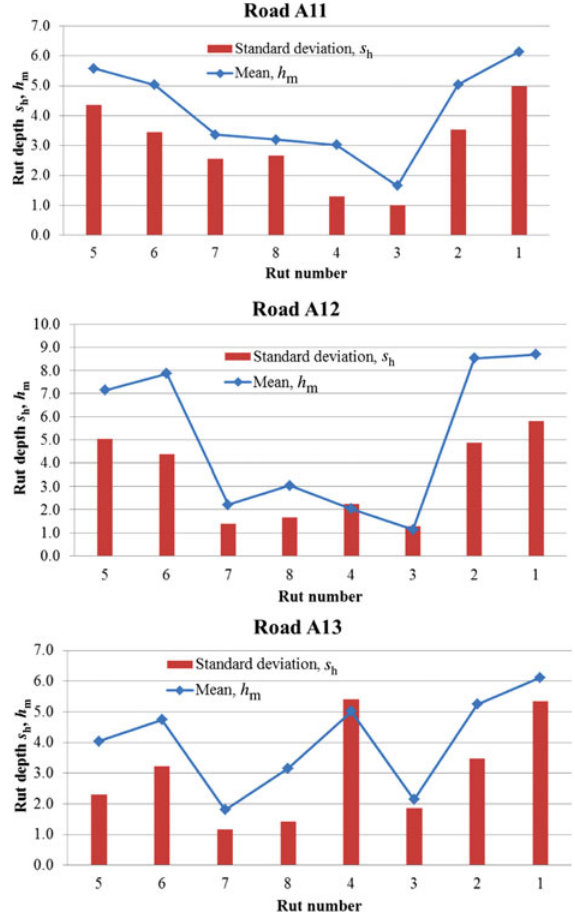
rut depth on Lithuanian highways having a dividing strip in the transverse direction